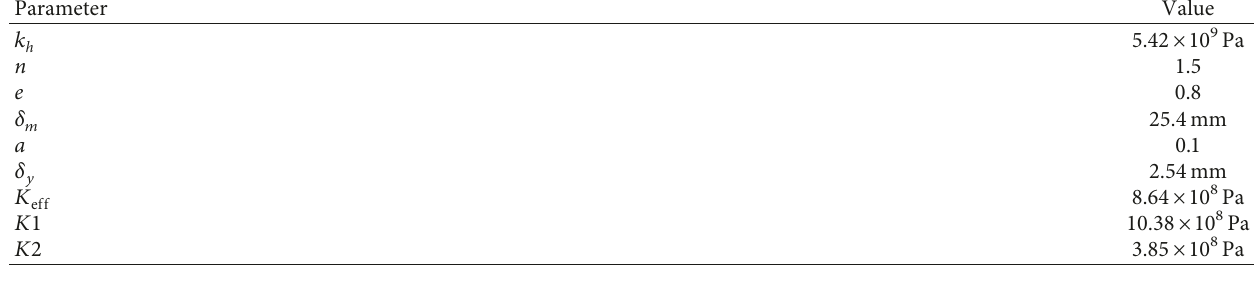
Table 3: Collision element parameters and corresponding